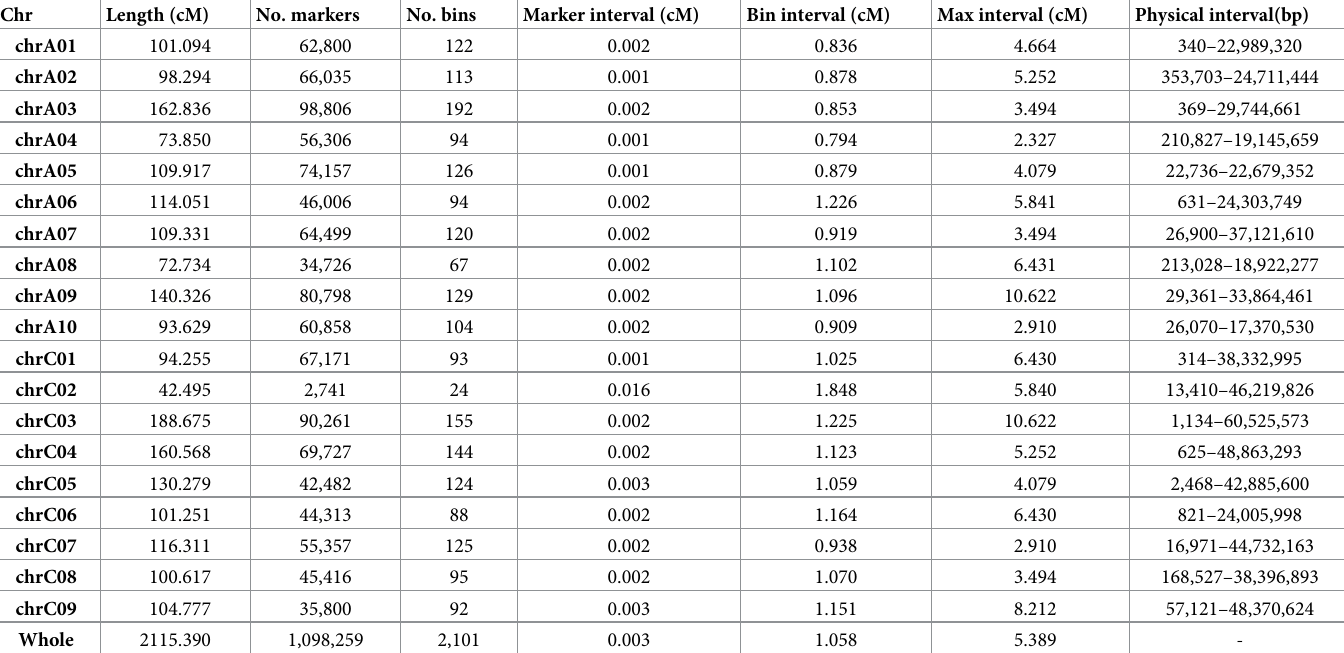
Table 1. Statistics of genetic linkage map information.